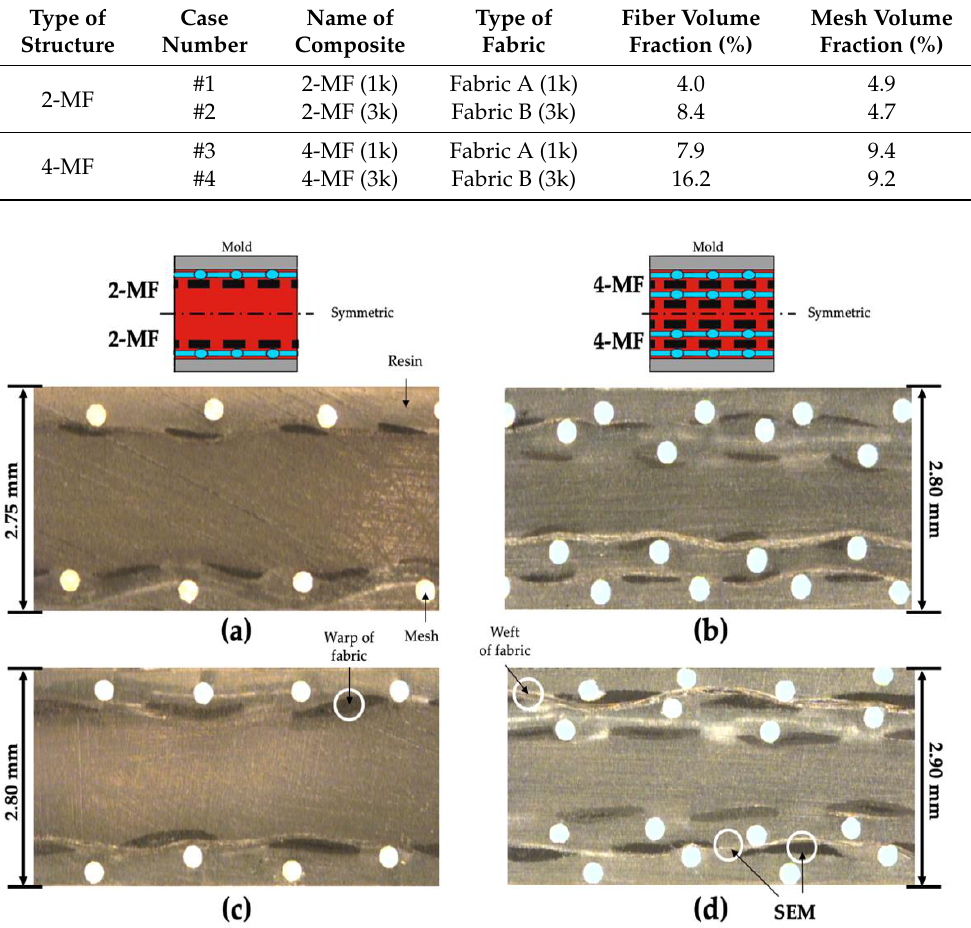
Figure 8. Optical microscopy images of the cross-section of the molded composites: ( a ) 2-MF (1k); ( b ) 4-MF (1k); ( c ) 2-MF (3k); ( d ) 4-MF (3k).